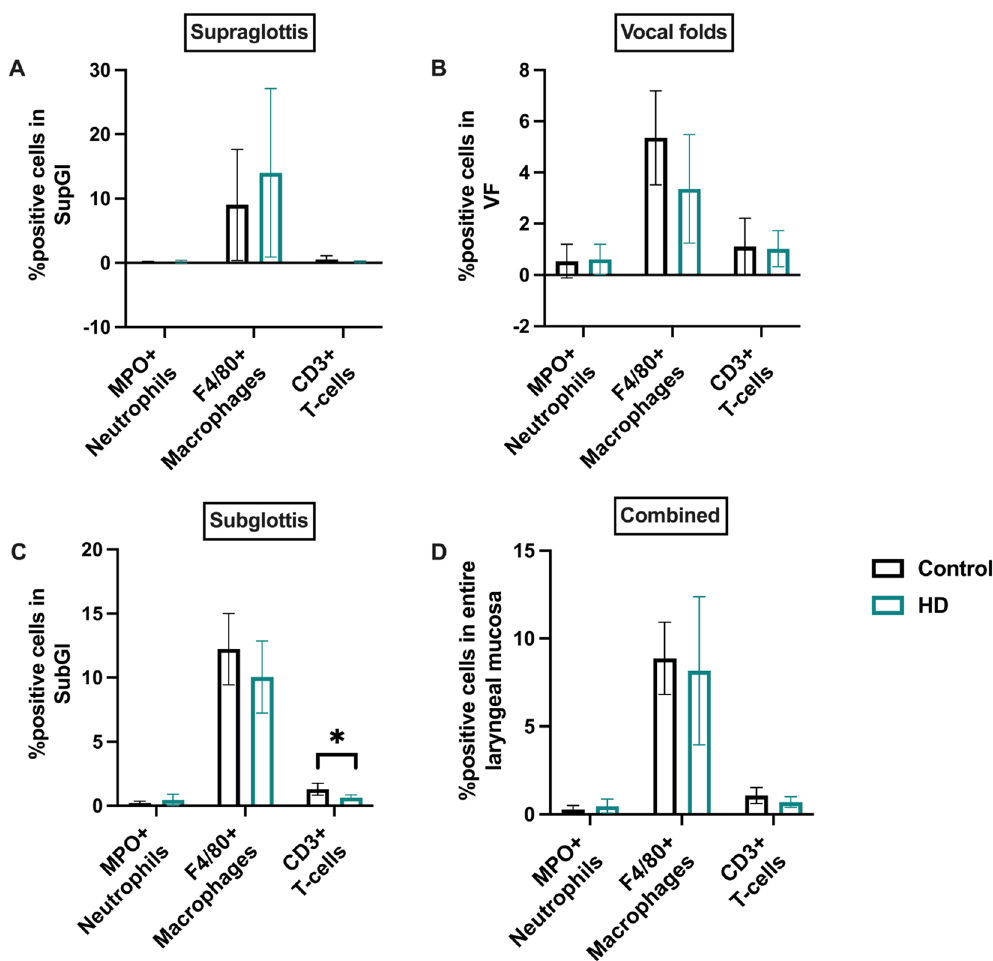
Figure 7. Quantification of immune cells in the laryngeal mucosa. HD CSE had no impact on the MPO + neutrophils and F4/80+ macrophages levels in the supraglottis ( A ), vocal folds ( B ), subglottis ( C ), and when averaged across entire laryngeal mucosa including the aforementioned regions ( D ). CD3 + T-cells were significantly decreased in the subglottic laryngeal regions ( C ). Despite the observed significant downregulation, CD3+ T-cells were unaltered in the supraglottic ( A ) and vocal fold ( B ) regions and when averaged across entire laryngeal mucosa ( D ). Bar graphs show the mean with SEM. * p ≤